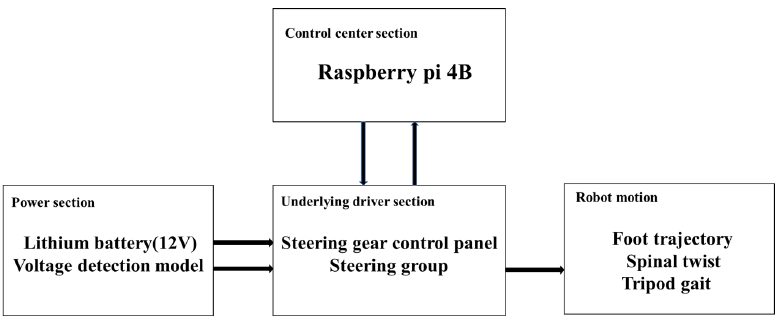
Figure 16. Diagram of robot control design.